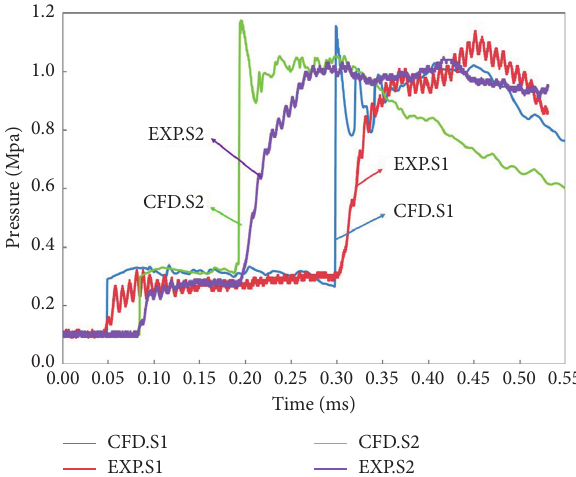
Figure 6: Pressure histories for the case with closed end in the driven